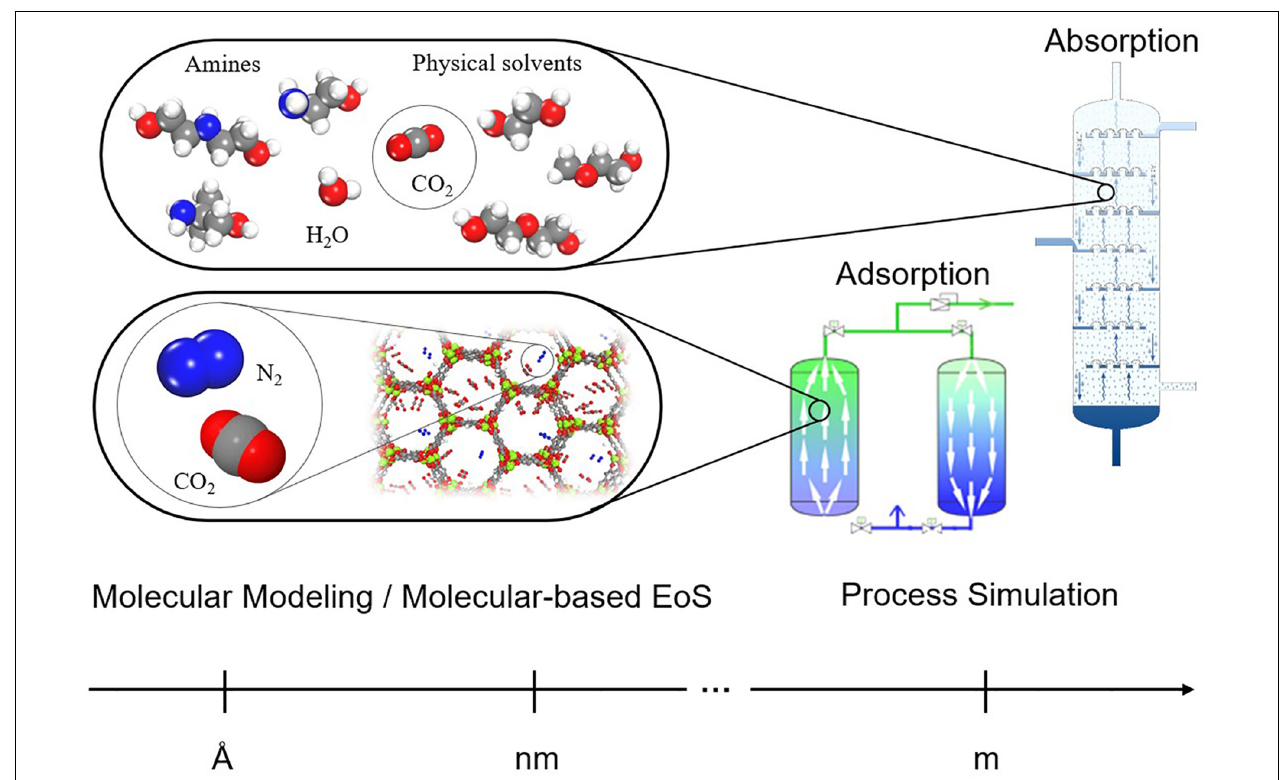
FIGURE 1 | Schematic representation of the length scales involved in the modeling tools used in this work.